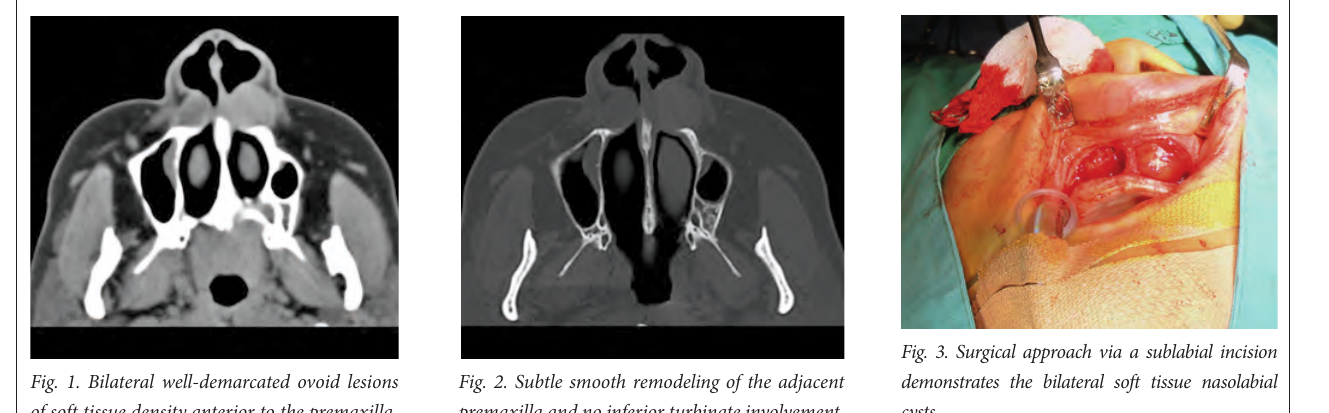
Fig. 1. Bilateral well-demarcated ovoid lesions of soft tissue density anterior to the premaxilla.